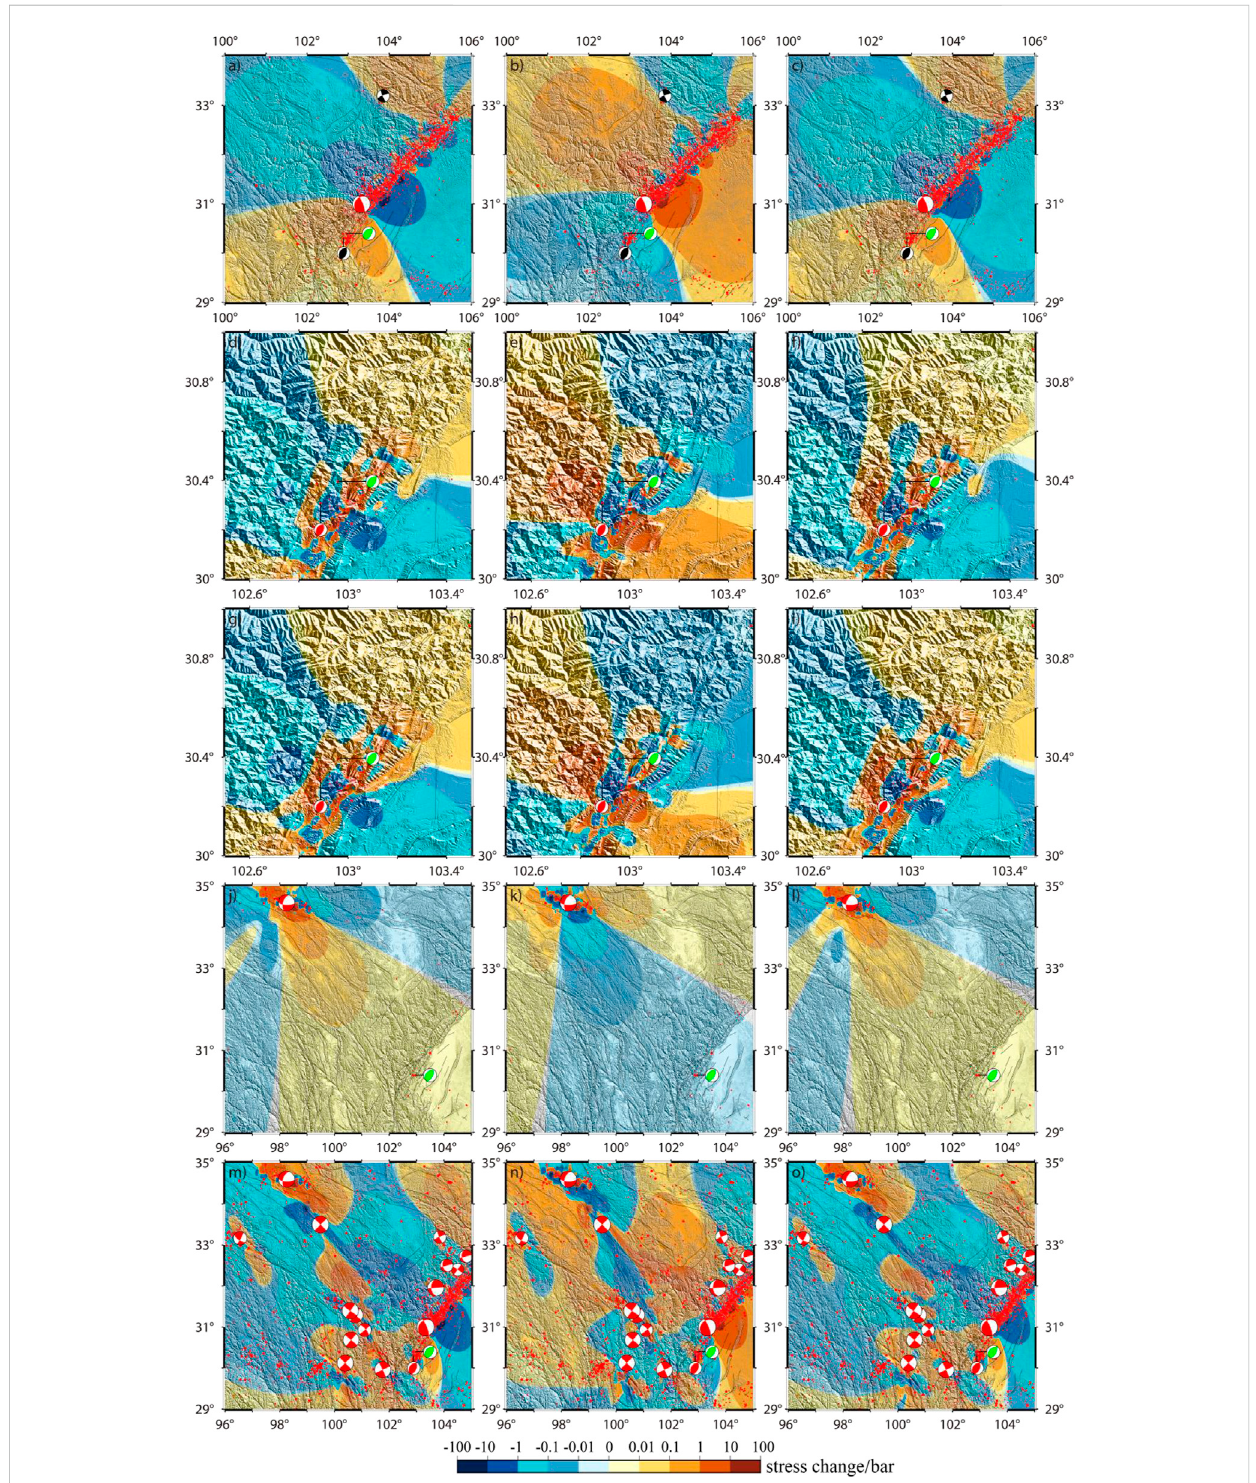
FIGURE 2 Contour map of Coulomb stress change in the 2022 Lushan earthquake. The red beach balls are the source events, the green beach balls are the receivingevents,andtheblackbeachballsareeventsbetweenthesourceandreceiving events. (A – C) Effectsofpostseismicshearstresschange,normal stress change, and Coulomb stress change of the 2008 Wenchuan earthquake on the 2022 Lushan earthquake, respectively. (D – F) Same display (coseismic)as for effects of the 2013 Lushanearthquakeon the2022 Lushan earthquake. (G – I) Same display (postseismic) as for effects of the2013 Lushan earthquake on the 2022 Lushan earthquake. (J – L) Same display (postseismic) as for effects of the 2021 Maduo earthquake on the 2022 Lushan earthquake. (M – O) Same display (postseismic) as for effects of historical earthquakes on the 2022 Lushan